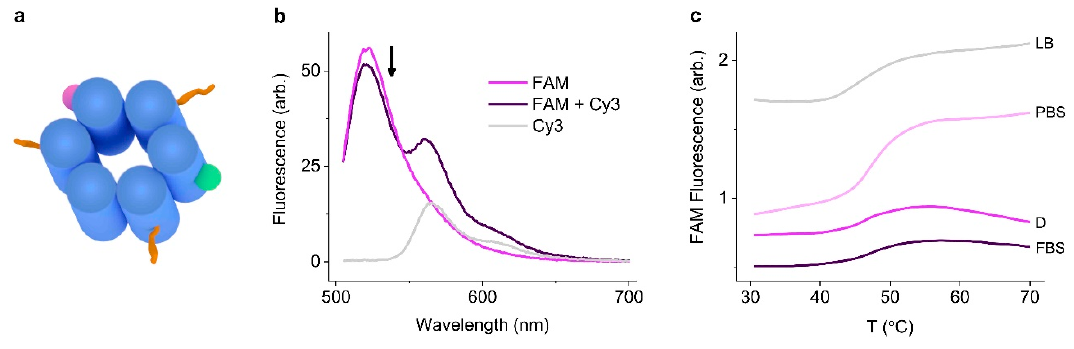
Figure 3. Determining the thermal stability of DNA nanopores in biological media using the Förster resonance energy transfer (FRET) pair labeled DNA nanopores. ( a ) Representation of fluorescein (FAM) ( purple ) and Cy3 ( green ) fluorophores incorporated into the DNA nanopore constructs; ( b ) fluorescence emission spectra of FAM (donor) and Cy3 (acceptor) labeled DNA nanopores, excitation at 495 nm, the donor emission is decreased in the presence of the acceptor in the assemble pore construct; ( c ) fluorescence donor emission thermal melting profiles of NP-3C in the stated buffers. The different fluorescence intensities reflect how the applied buffer system influence fluorophore emission. Table 2. Melting temperatures of DNA nanopore constructs in stated salt and media systems. Errors were identified from three independent experiments.